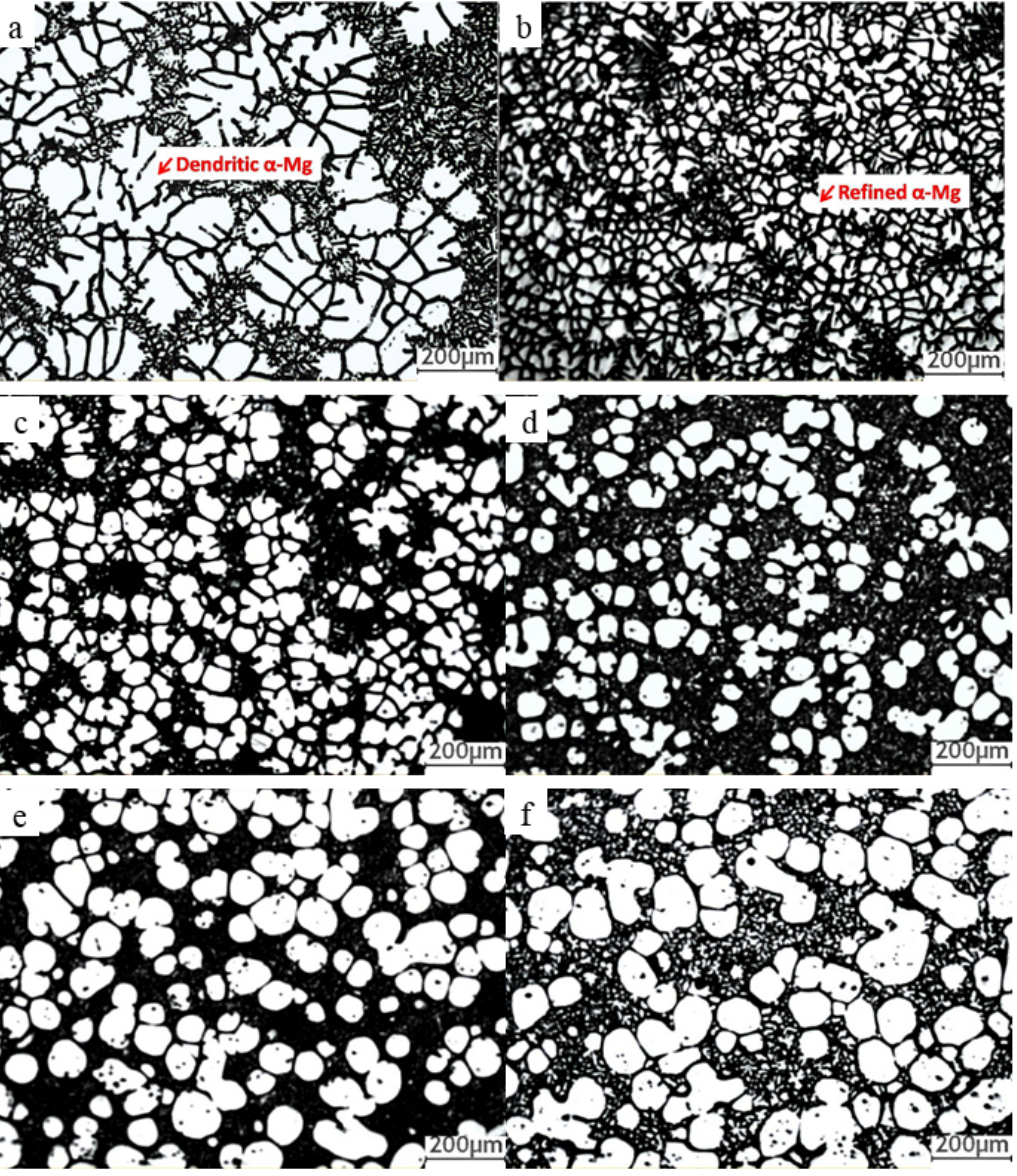
Figure 6. Microstructure of AM60 alloy under conventional pouring ( a ) and poured by self-inoculation process and then held at 595 °C with ( b ) 0 s; ( c ) 30 s; ( d ) 60 s; ( e ) 240 s; ( f ) 480 s.